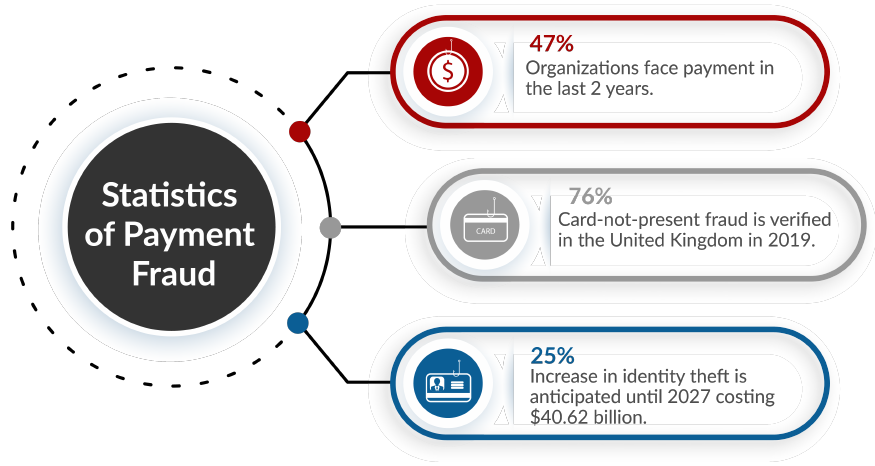
Figure 1. Statistics of payment